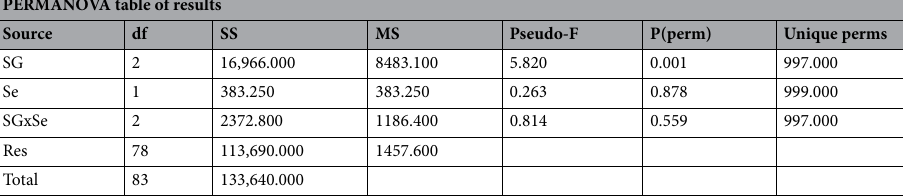
Table 4. PERMANOVA result showing the significant differences in the relative abundance of macroinvertebrate functional feeding groups variables among the three site groups in the Niger Delta Region Streams during the study period (2008–2012). SG site group, Se season, Res residuals.